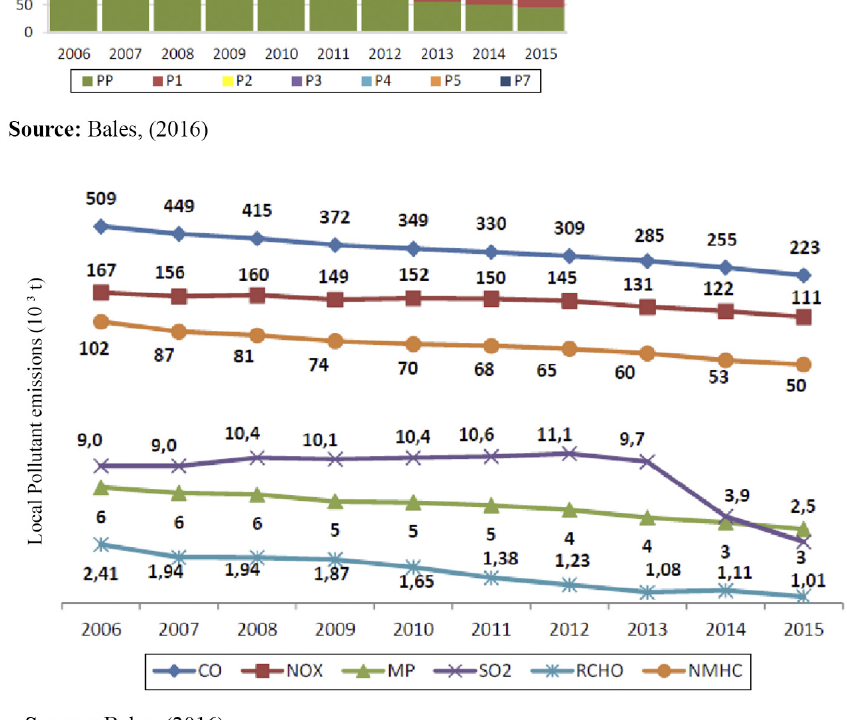
fl eet evolution according the PROCONVE standards in the